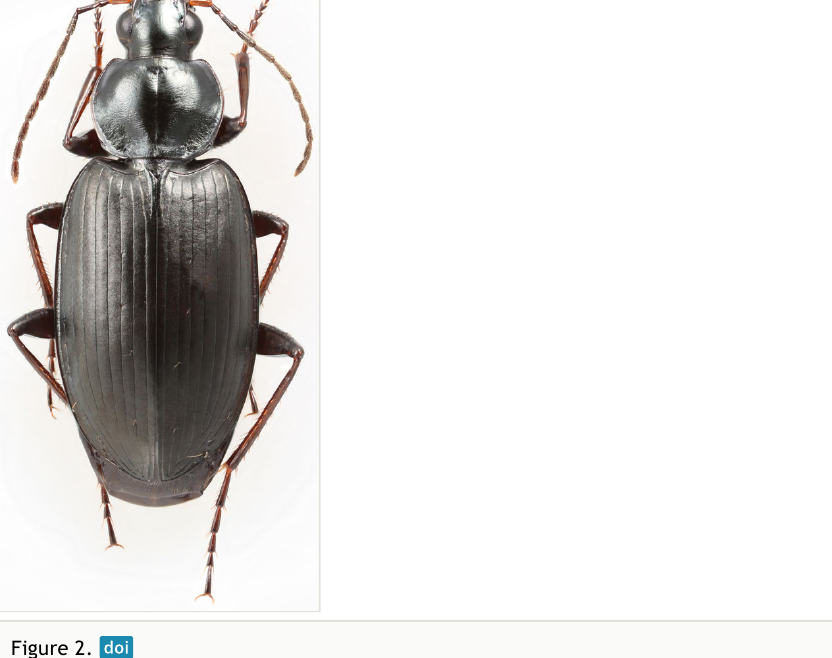
Agonum ( Agonum ) placidum (Say), a 10 mm long female collected in the Grey Cli ff area of the GBNP (EMEC344764). This species was found during the study and is a new state record